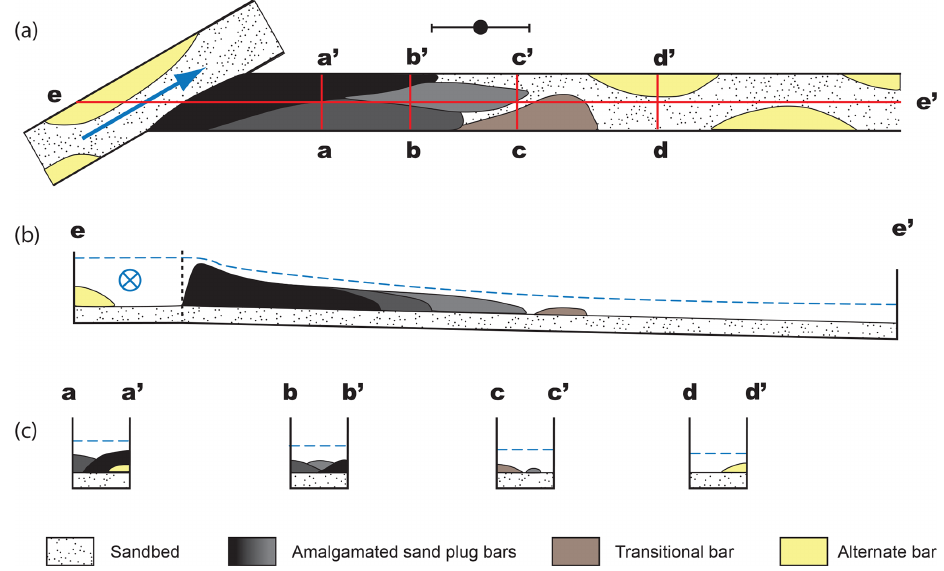
Figure 9. Conceptual architecture of sand plug derived from experimental observations: overhead view (a) , longitudinal profile (b) and transverse sections (c)